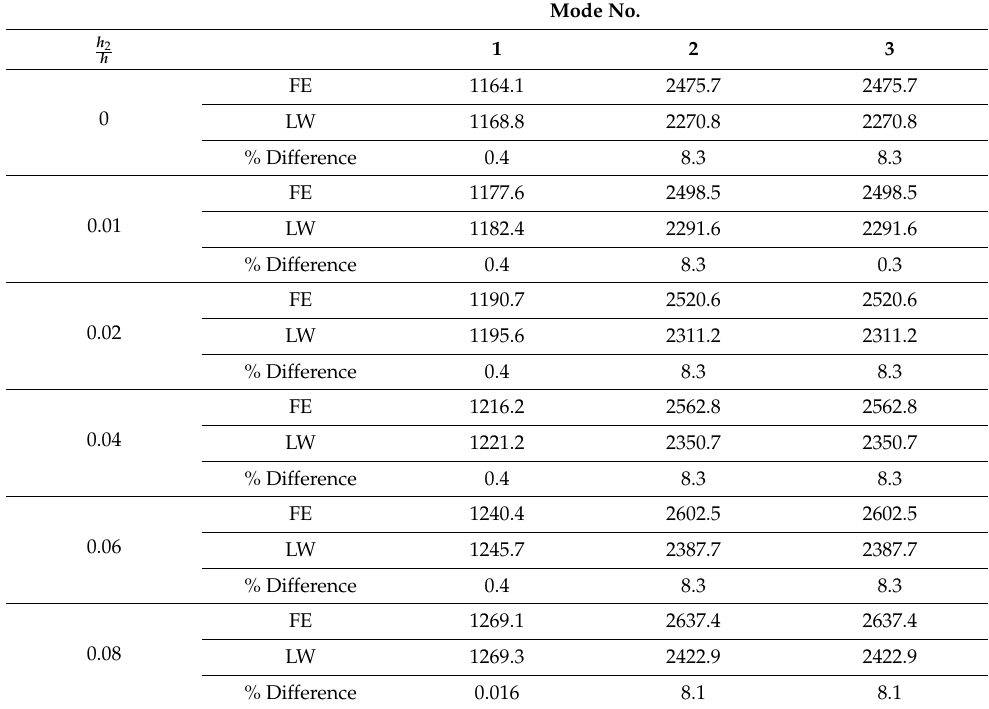
Table 13. Comparison of frequencies (HZ) based on LT and FE findings (increasing the adhesive